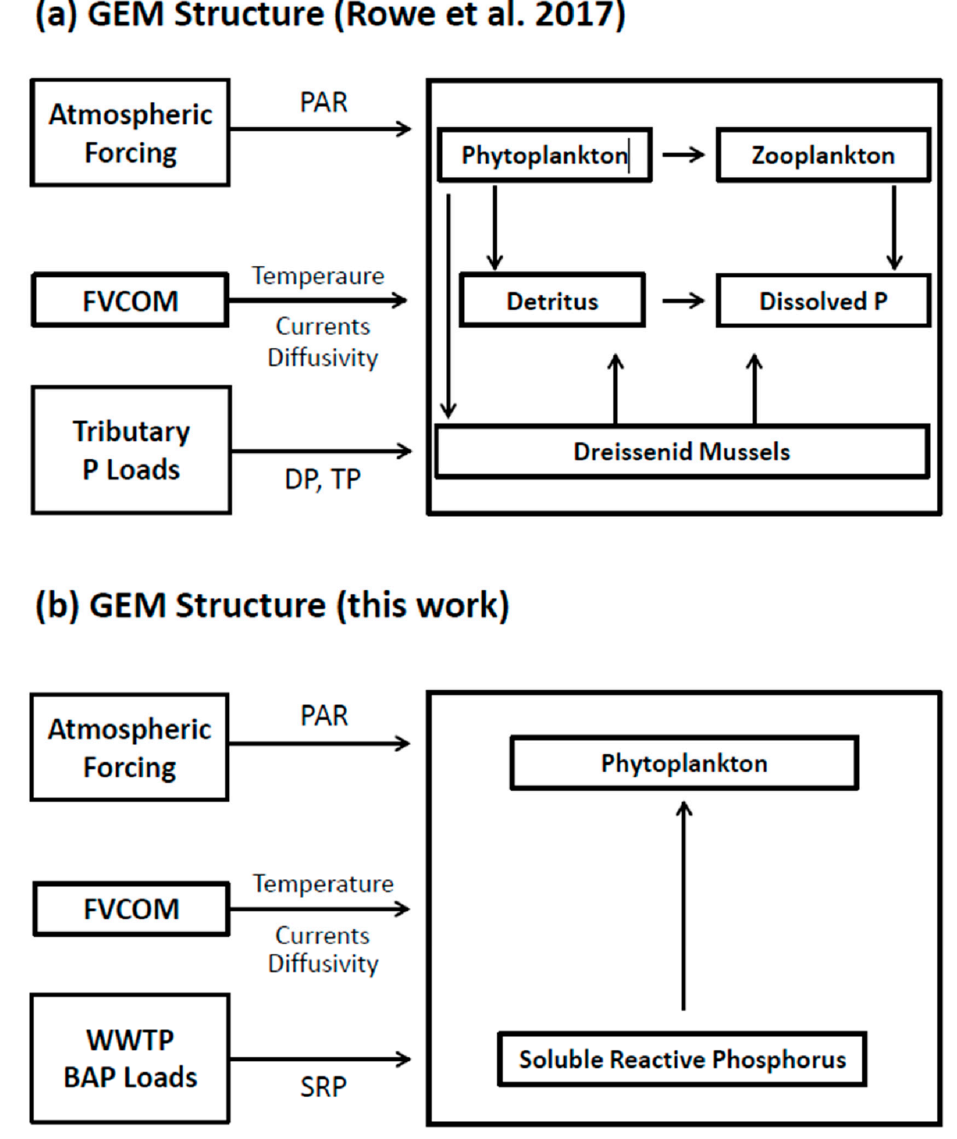
Figure 5. Conceptualization of the phosphorus–phytoplankton dynamics (GEM) model as applied ( a ) by Rowe et al. [29] and ( b ) in this